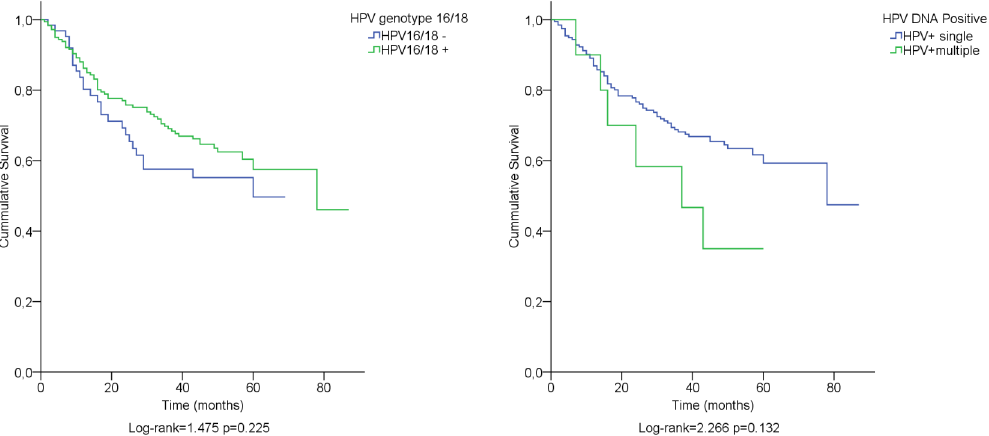
Fig 2. Kaplan-Meier survival curves stratified by the presenceof HPV genotype 16/18 (left panel). ICC survival stratified by single or multipleHPV infection(right